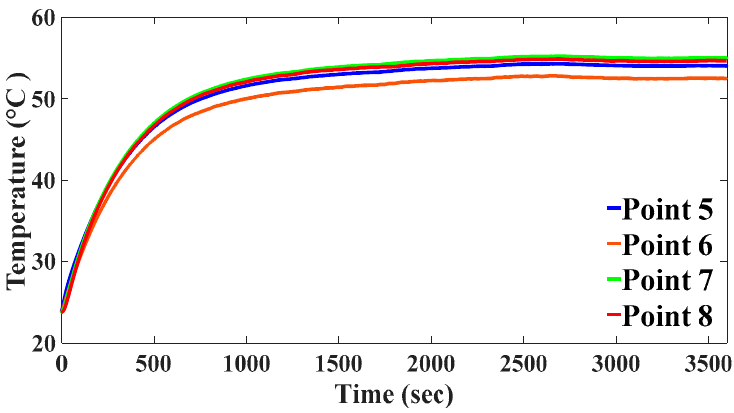
Figure 27. Type II heat-source temperature. Table 7. Heating source experiment